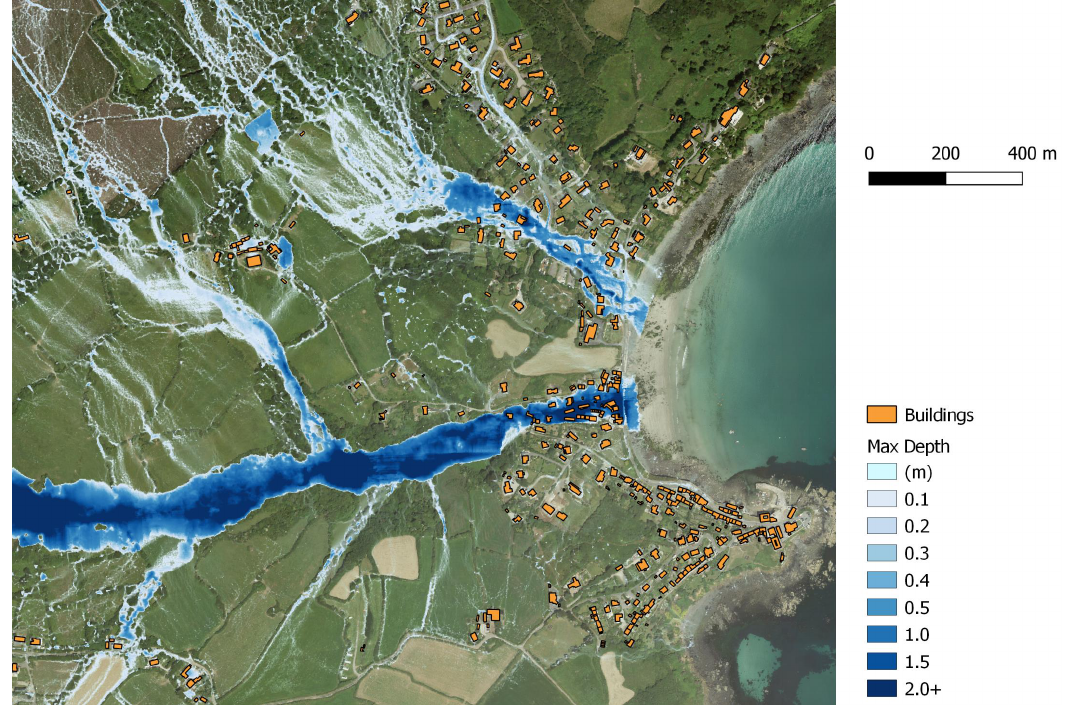
Figure 3. Hydraulic modelling, using radar observations, of the Coverack flood, showing the flooding extent and depth for the